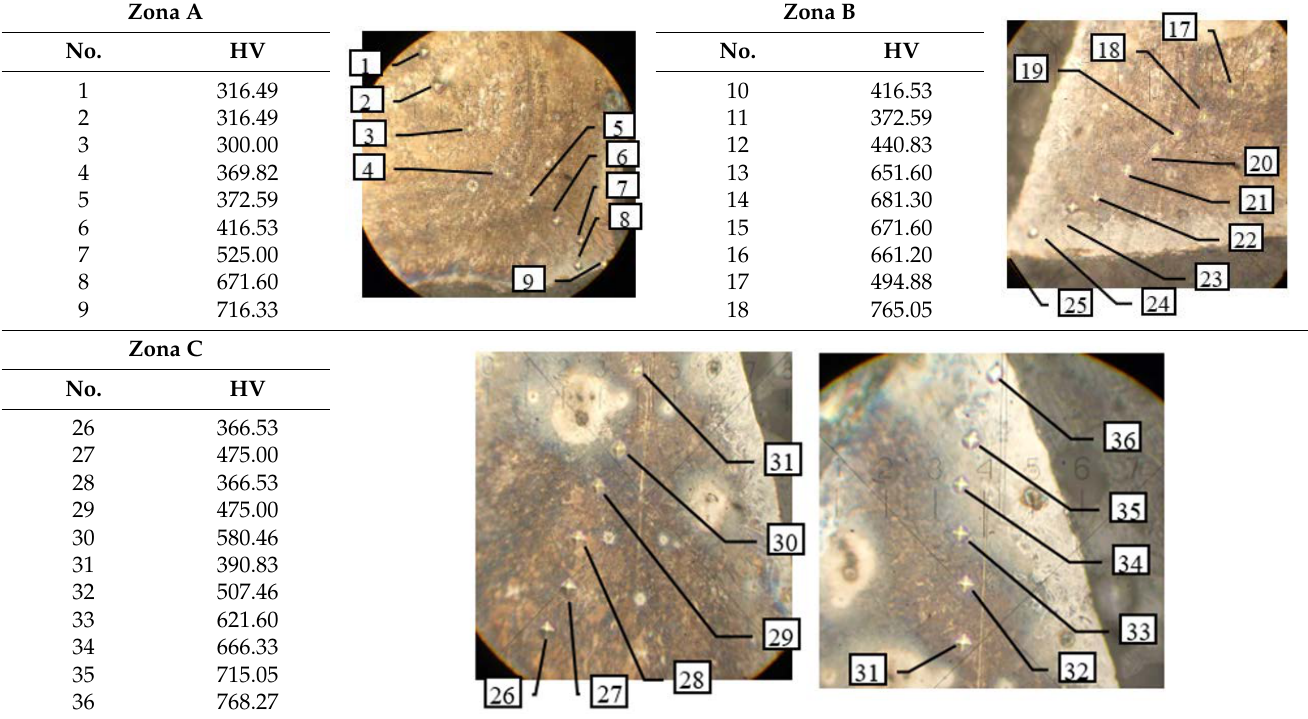
Table 4. Microhardness values of the metallographic constituents in areas A, B, and C along with the images of the marks measured for the ionic screen nitrided sample.